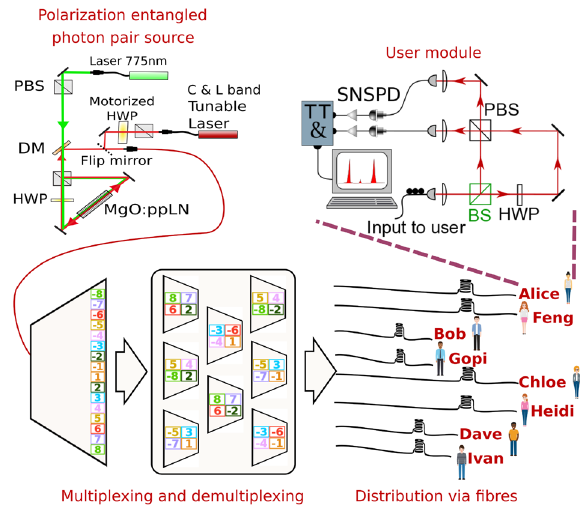
Fig. 2 Experimental setup. The entangled photon pair source is based on a type-0 MgO:ppLN crystal pumped bidirectionally by a 775.1 nm laser. A fl ip-mirror and motorised half wave plate (HWP) are used to couple a tunable telecom laser into the output fi bre for polarisation control. The multiplexers/demultiplexers combine the shown combination of wavelength channels and distribute them to all eight users. The channel numbers are shown here plus 34 correspond to the standard ITU 100 GHz DWDM grid. Due to energy conservation photons in channels {1, − 1}, {2, − 2}, and so on are the only ones entangled. Each user is connected to the central hub by one fi bre. The fi gure also shows the setup of each user ’ s polarisation analysis and detection module. (PBS Polarisation beam splitter, DM Dichroic mirror, SNSPD Superconducting nanowire single photon detector, TT Time tagger, BS non-polarising Beam